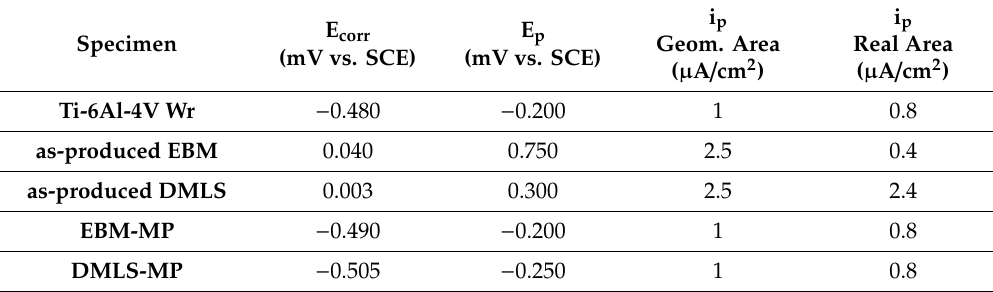
Table 5. Summary of corrosion parameters of the potentiodynamic polarisation analysis.